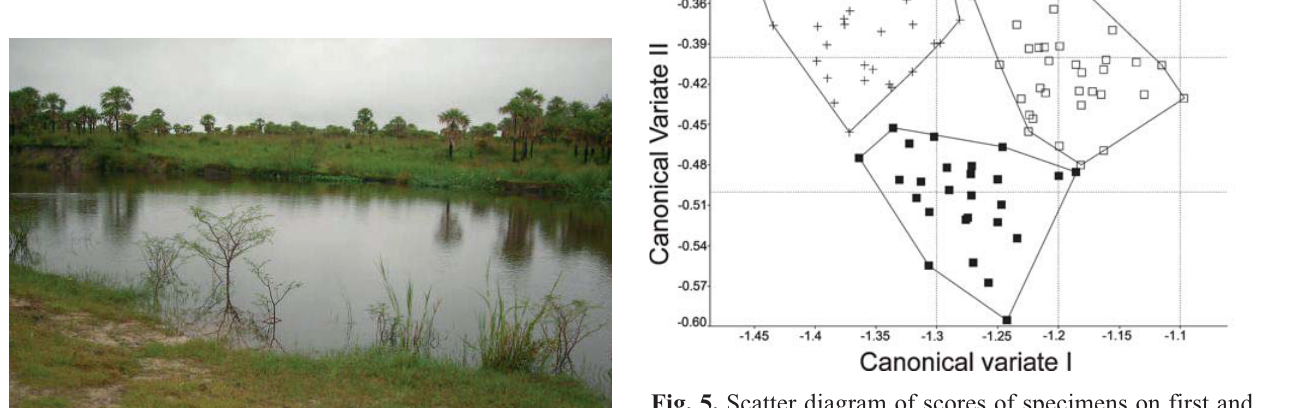
Fig. 5. Scatter diagram of scores of specimens on first and second axes of Size-Free Canonical Variate Analysis of Mi- croglanis carlae (cross, n = 30), M. garavelloi (open square, n = 32), and M. parahybae (dark square, n = 26).